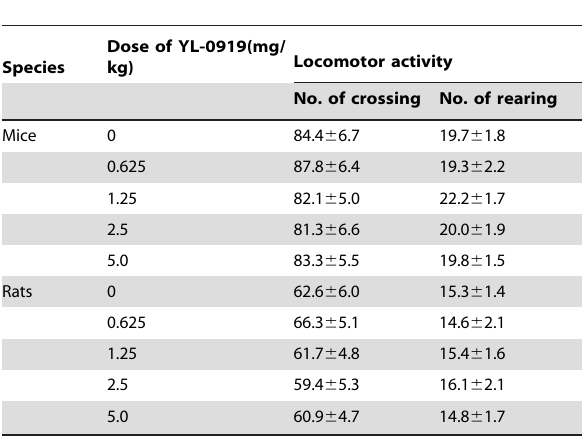
Table 5. The effect of YL-0919 on locomotor activity in mice and